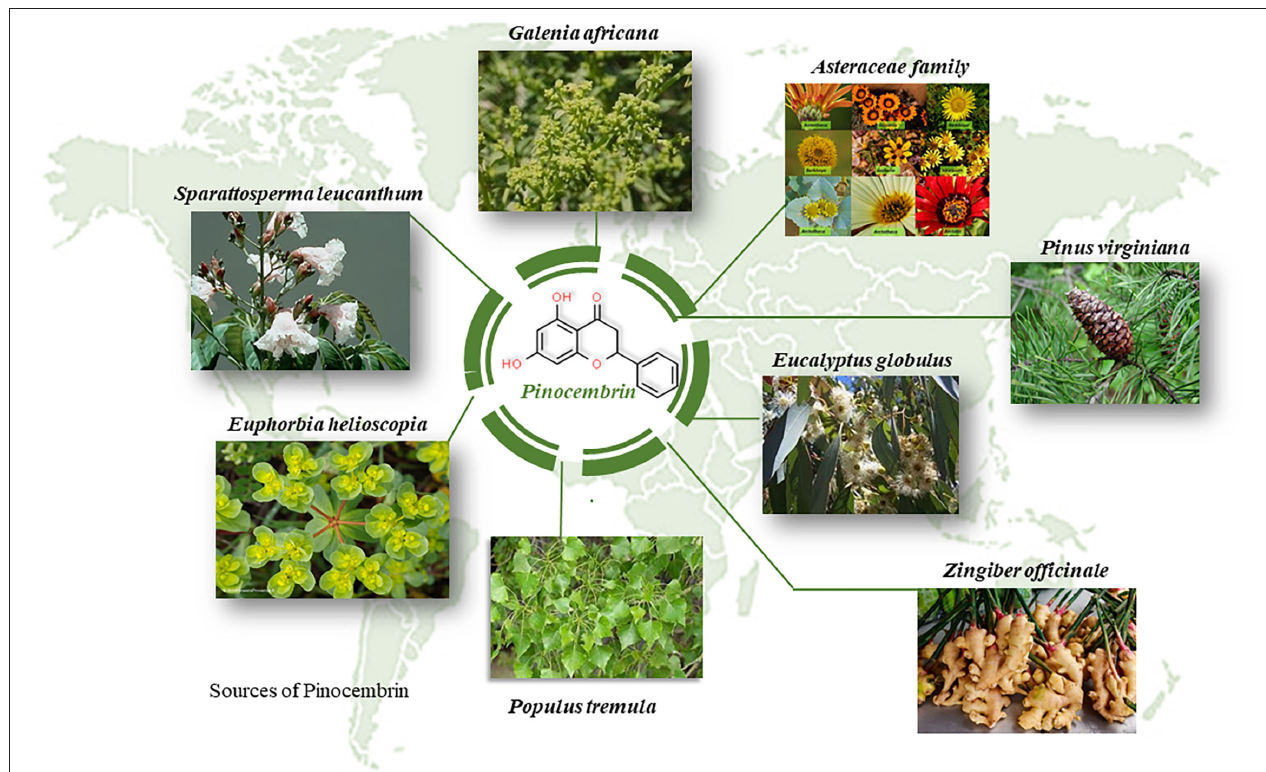
FIGURE 7 | Plant sources of pinocembrin all over the globe. Pinocembrin is a plant derived flavonoid with numerous therapeutic benefits.